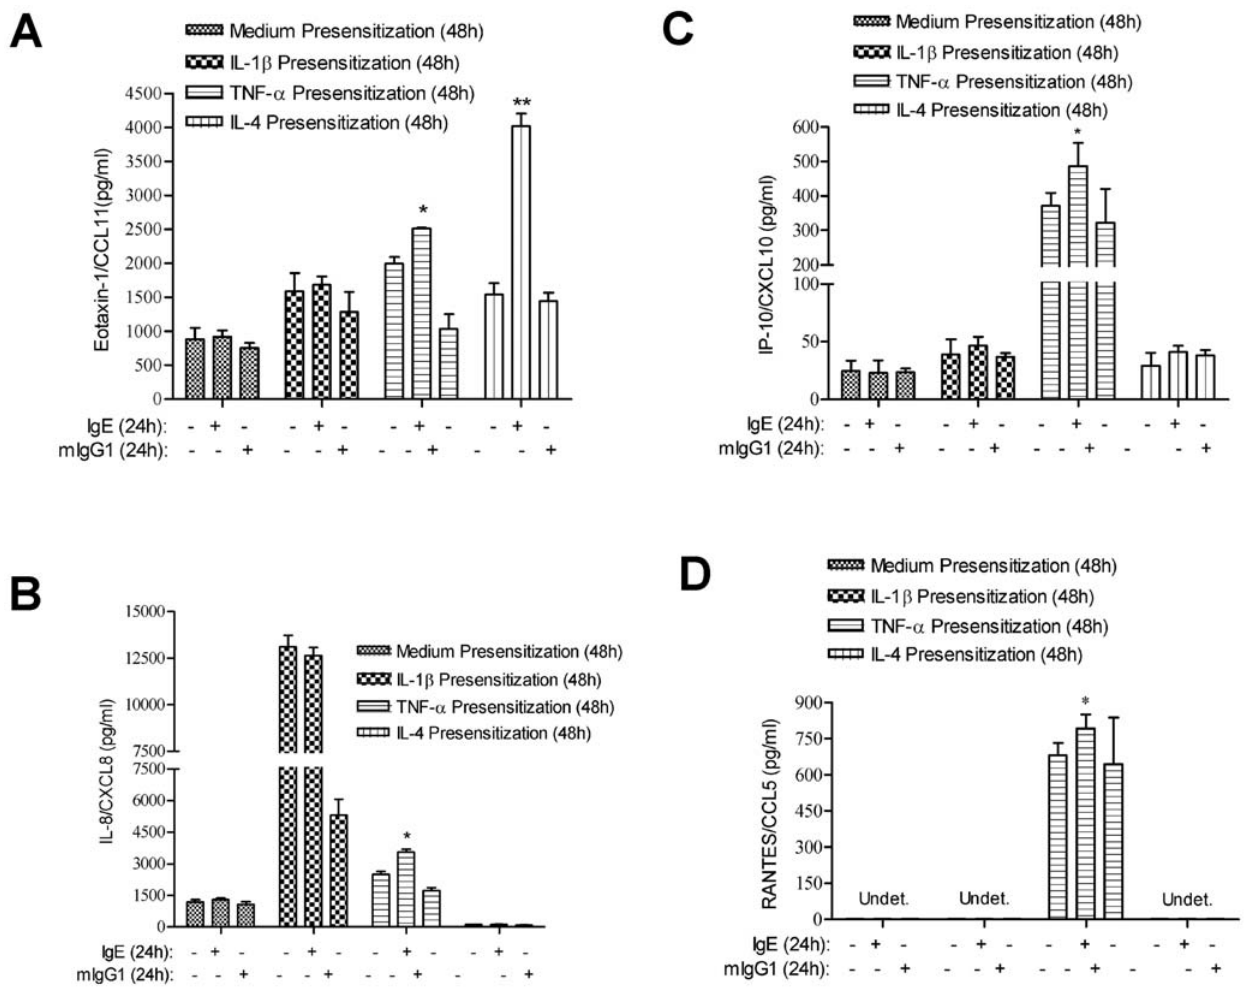
Figure 3. TNF- a pre-sensitization augments multiple CC and CXC chemokines release following IgE stimulation. Primary human B/TSM cells were cultured in presence of 10 ng/ml each of TNF- a , IL-1 b , or IL-4 for 48 h. Cells were then washed twice, and stimulated with either IgE (1 m g/ ml), mIgG1-MOPC21 (1 m g/ml) or left unstimulated (medium alone) for another 24 h. Culture supernatants were used for (A) eotaxin-1/CCL11, (B) IL-8/ CXCL8, (C) IP-10/CXCL10, and (D) RANTES/CCL5 measurement by ELISA. Data represents mean 6 SD of three independent experiments